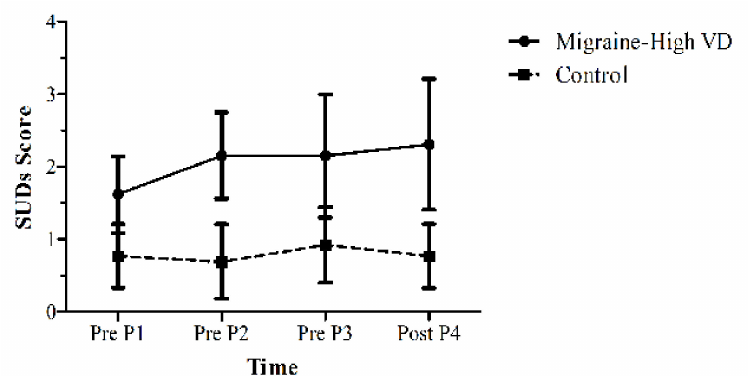
Figure 5. Mean SUDS scores for each group (N = 26, 13 per group) across four points, with three immediately before each test (Pre P1, Pre P2, Pre P3) and one immediately after P3 (labelled Post P4). The error bars represent 95%